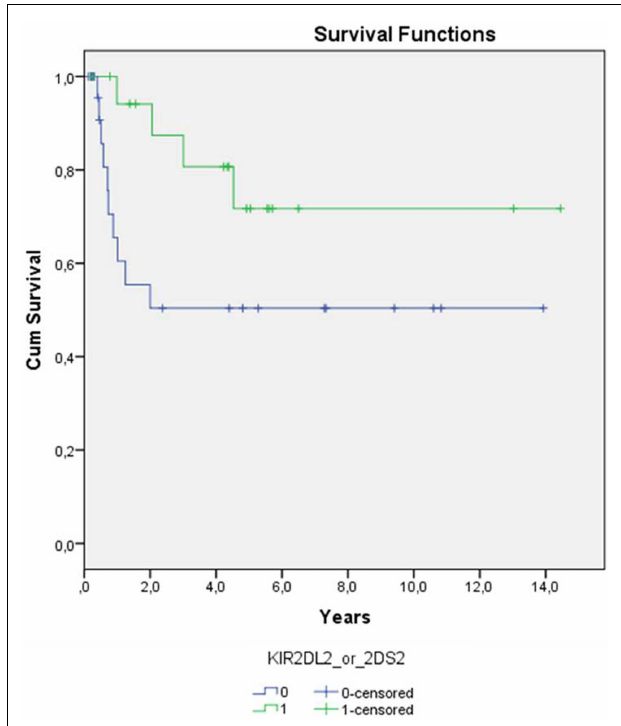
FIGURE 2 |Time from transplantation to relapse among patients with AML ( n = 47) is shown . Patients whose donors have either KIR2DL2 or KIR2DS2 ( n = 19, green line) have lower risk for relapse (log-rank p -value 0.059) than patients whose donors do not have those B haplotype defining KIR genes ( n = 28, blue line).